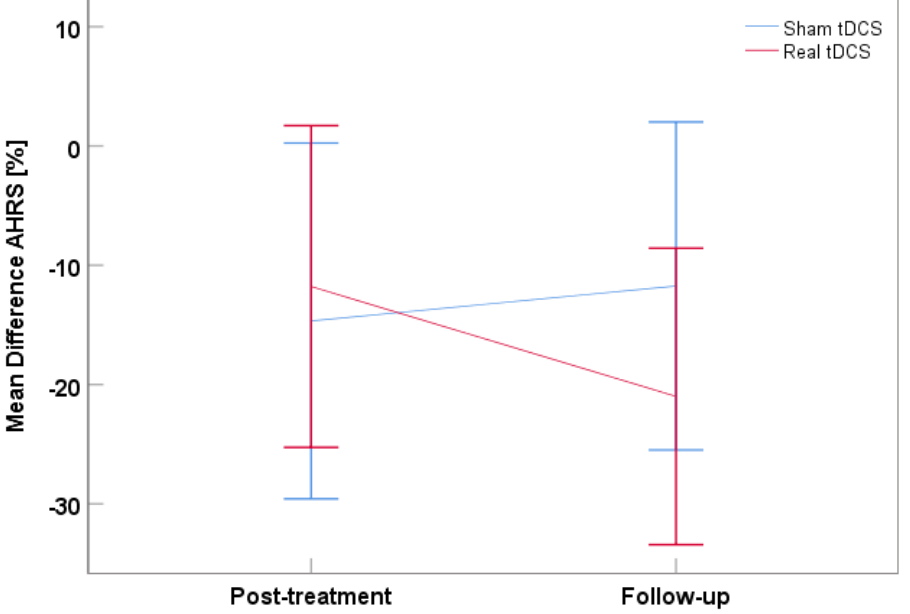
Figure 2. Mean difference for the AHRS score at post-treatment and follow-up with the real tDCS group in red and the sham tDCS groups in blue. Negative values represent a reduction, positive values an increase in AVH relative to baseline. Error bars denote 95% CI. Based on the AHCS (n = 20 ) , 5/11 (45.5%) of the participants in the real group and 5/9 (56%) of the sham group reported that their AVH scores improved ( χ² = 0.202, p = 0.653). The average improvement with real tDCS ( M = 24.9%, SD = 34%, range 0 − 99%) was not significantly different from sham improvement ( M = 21.7%, SD = 28%, range 0−85% ), ( F 18 = 0.42, p = 0.524). Only participants with real tDCS differed significantly from zero ( t 10 = 2.40, p = 0.038), but there was also a trend in the sham group ( t 8 = 2.28, p = 0.052), according to one-sample t-tests. Notably, none of the patients reported worse AVH after treatment. None of the other clinical or neurocognitive/general functioning measures showed any significant effects. The descriptive means and ANCOVA results are displayed in Table 3.